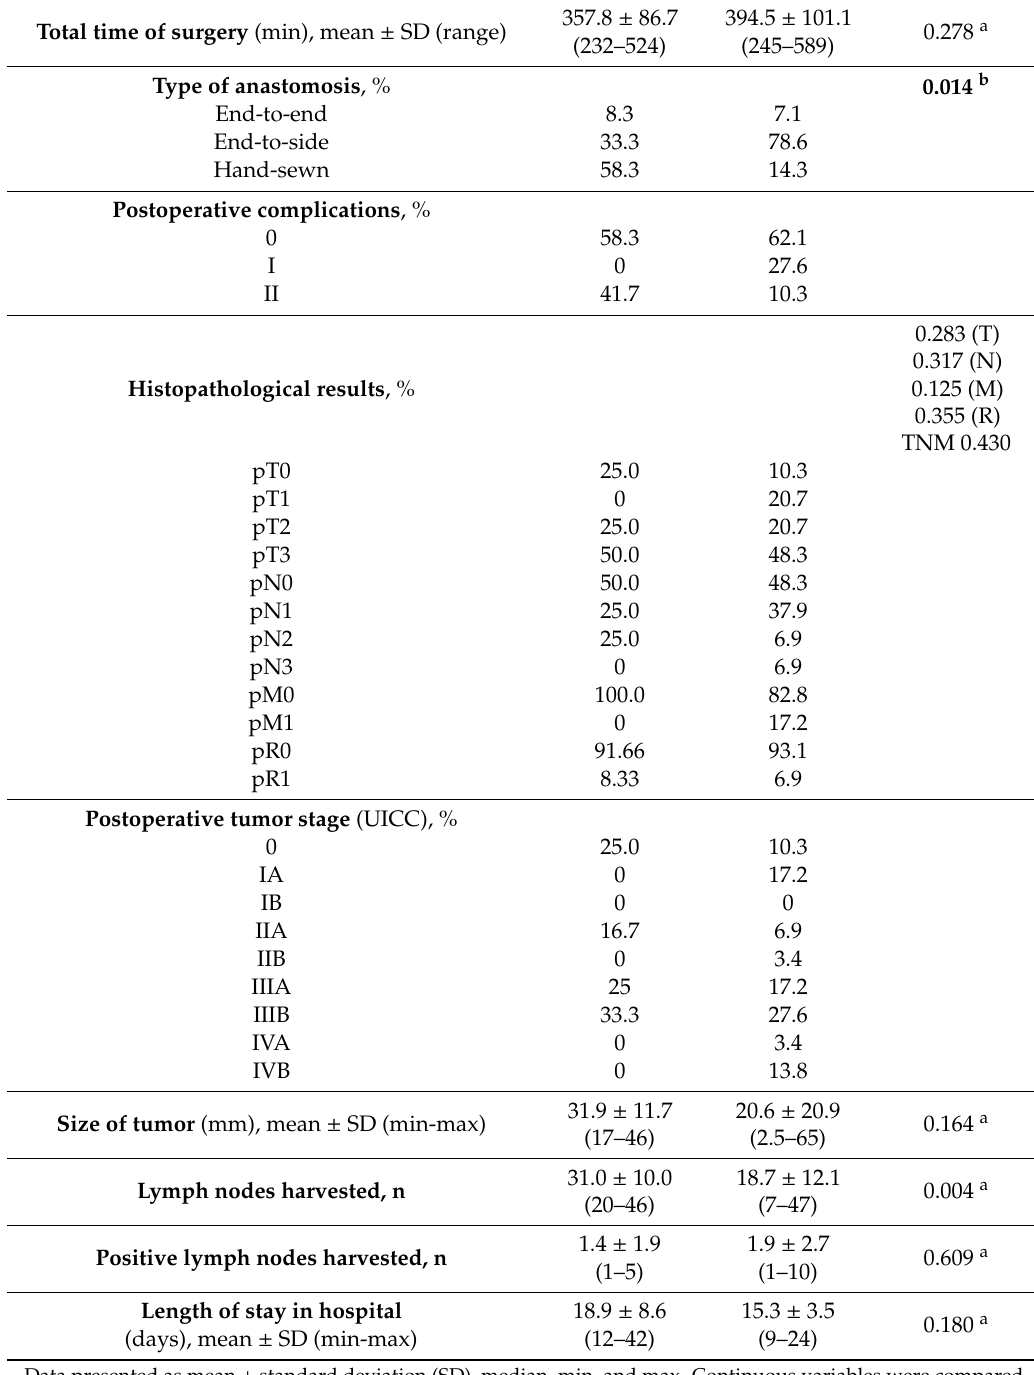
RAMIE OTE p -Value ( n = 12) ( n = 29)